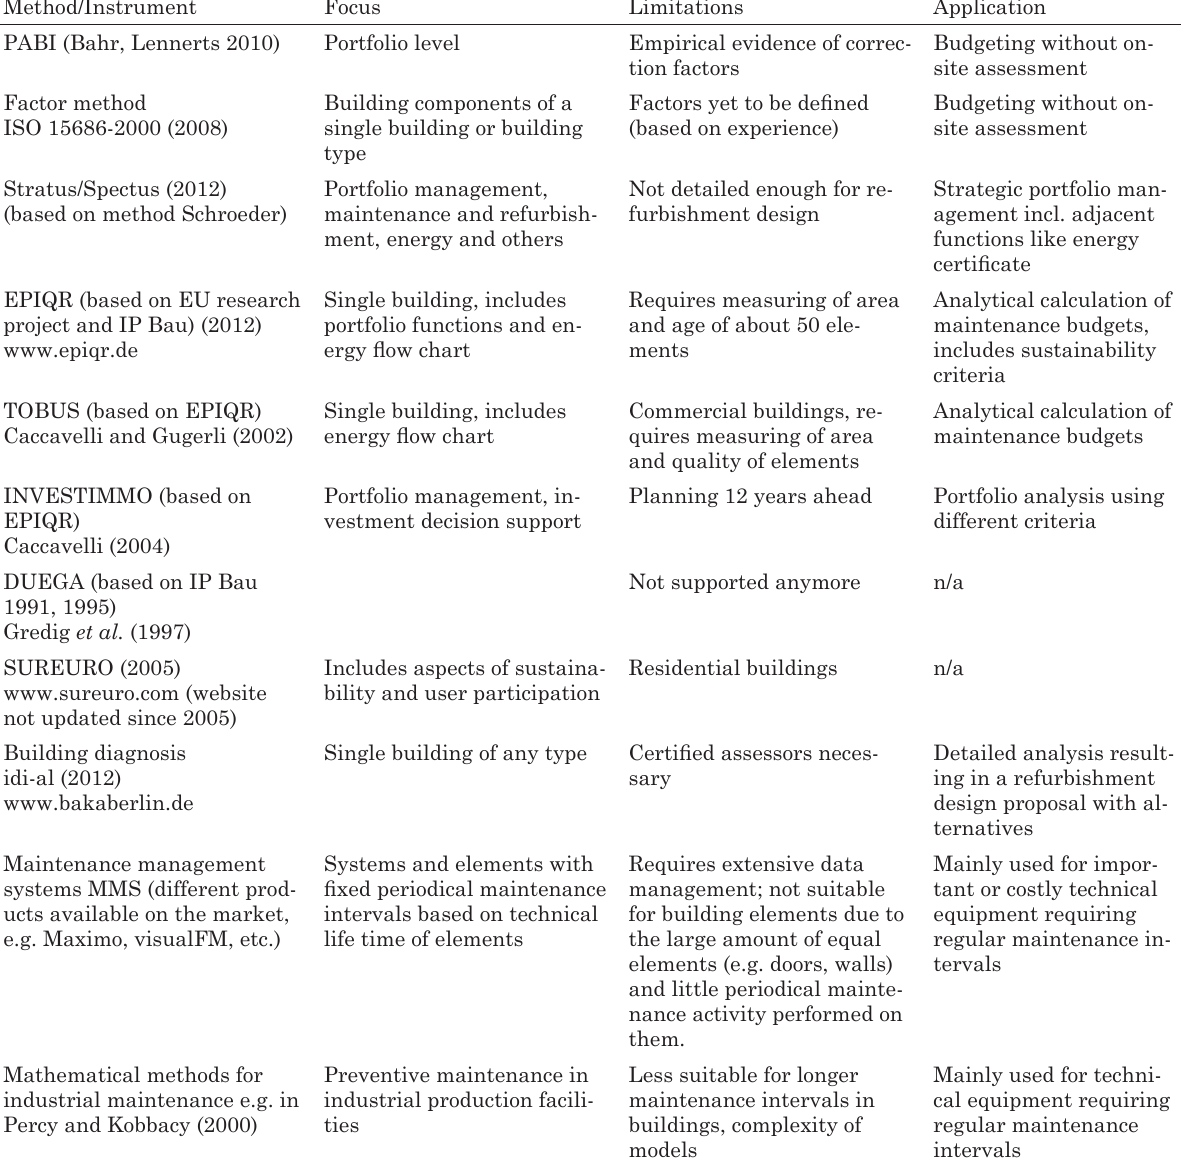
Table 3. Commented list of examples of maintenance budgeting and/or planning methods and instruments